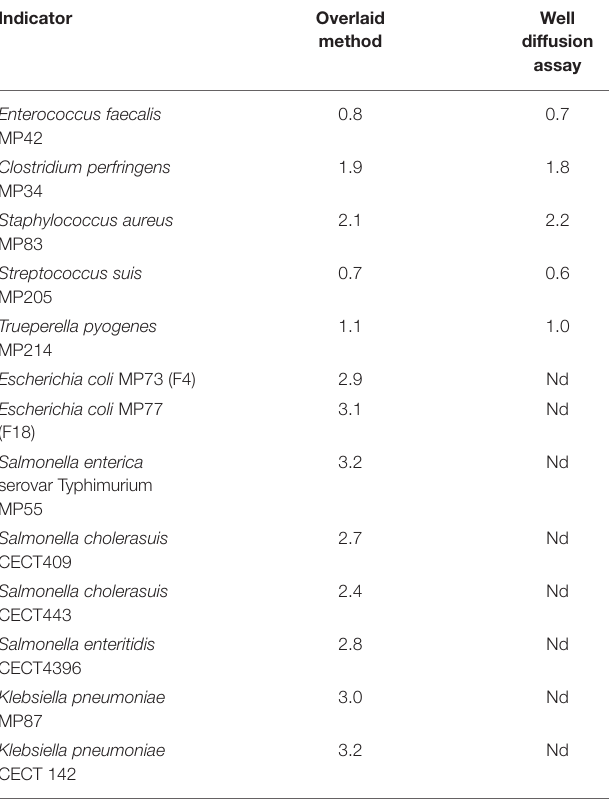
TABLE 2 | Minimum inhibitory concentrations (MICs) and cut-off values ( µ g/ml) for TABLE 1 | Antimicrobial activity of neutralized culture supernatants of L. salivarius the antibiotics included within the EFSA criteria (27) for L. salivarius MP100 (dimeter of the halos in cm). Indicator Overlaid Well method diffusion